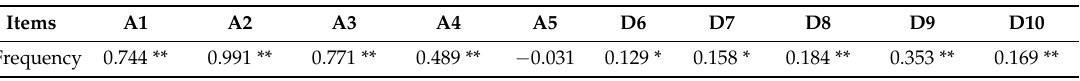
Table 6. The Pearson correlations of the frequency of use of fitness monitoring technology and their typology (items A = devices, D =